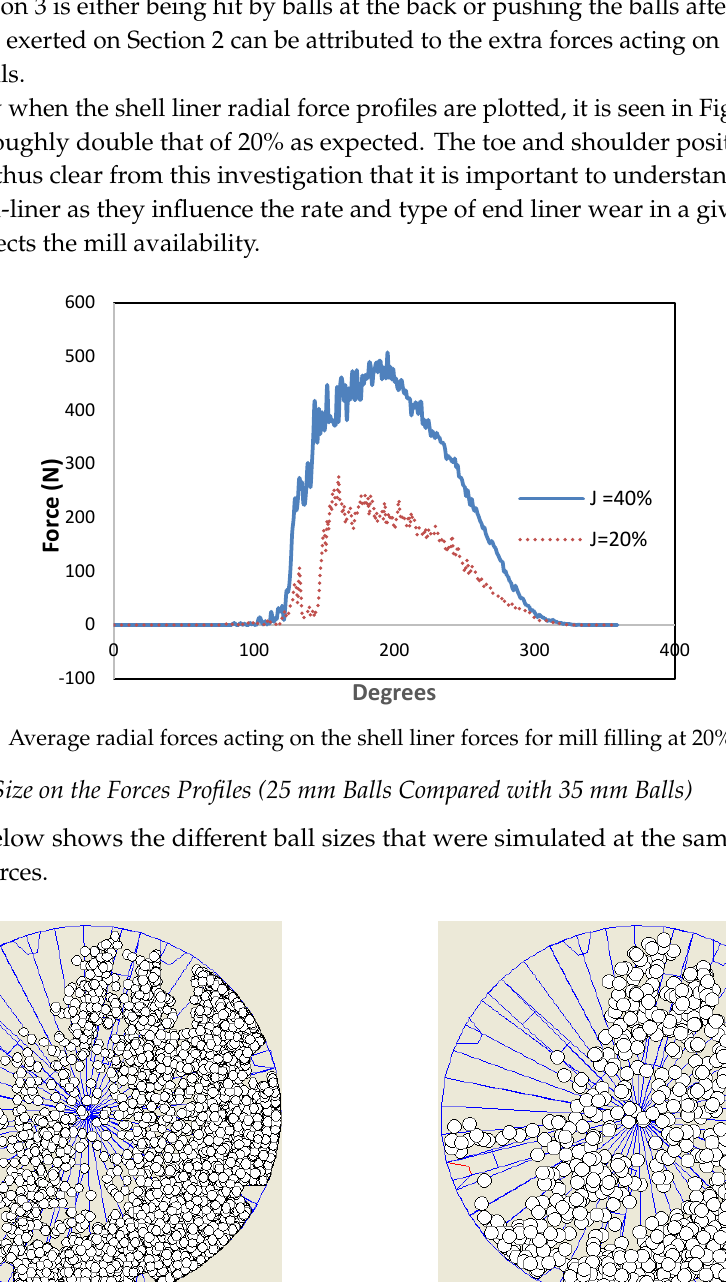
Figure 10. Tangential forces acting on the end liner when mill filling is increased to 40%.